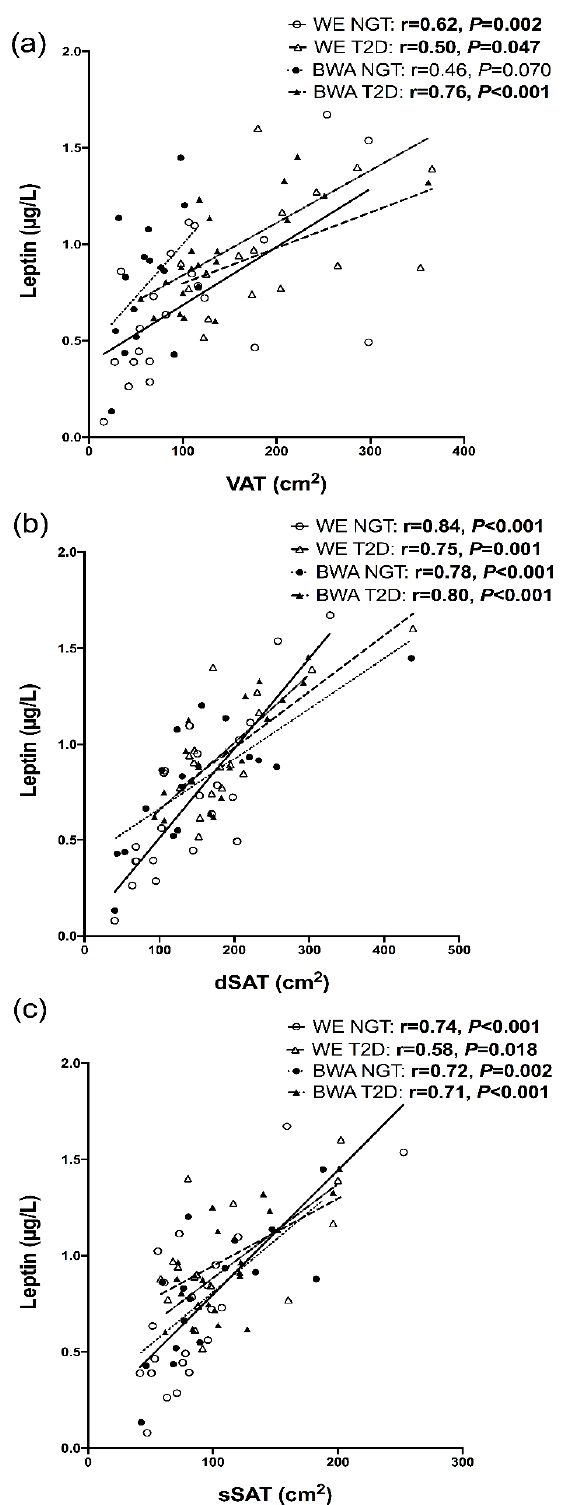
Figure 2. Relationships between leptin and visceral adipose tissue (VAT), ( a ), deep subcutaneous adipose tissue (dSAT), ( b ) and superficial SAT (dSAT), ( c ), in white European (WE) and black West African (BWA) men with normal glucose tolerance (NGT) and type 2 diabetes (T2D). Leptin was log transformed to achieve a normal distribution. Bold p -values indicate significance of <